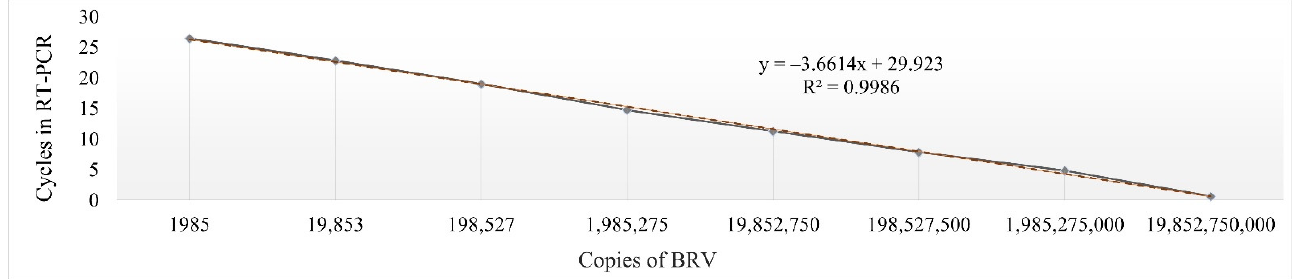
Figure 3. The standard curve of RT ‐ PCR detecting BRV. The plasmids were used to establish the standard curve and the software Microsoft Excel was used to analyse the relationship of Ct values and plasmid copy numbers.